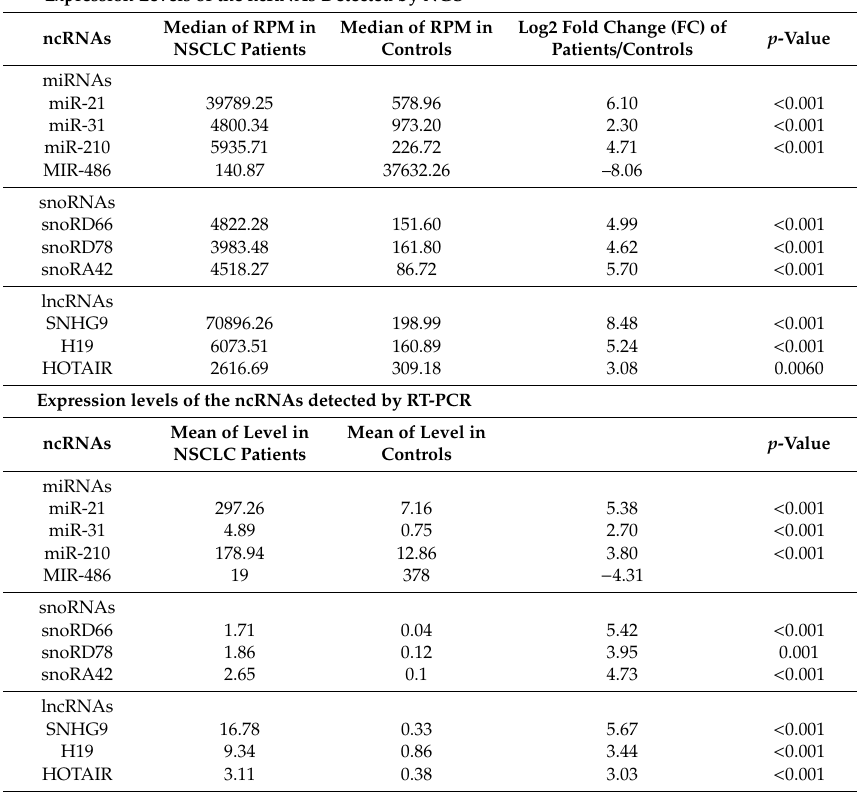
Table 4. Expression of 10 ncRNAs detected by NGS and RT-PCR in sputum of stage I non-small cell lung cancer patients vs. cancer-free